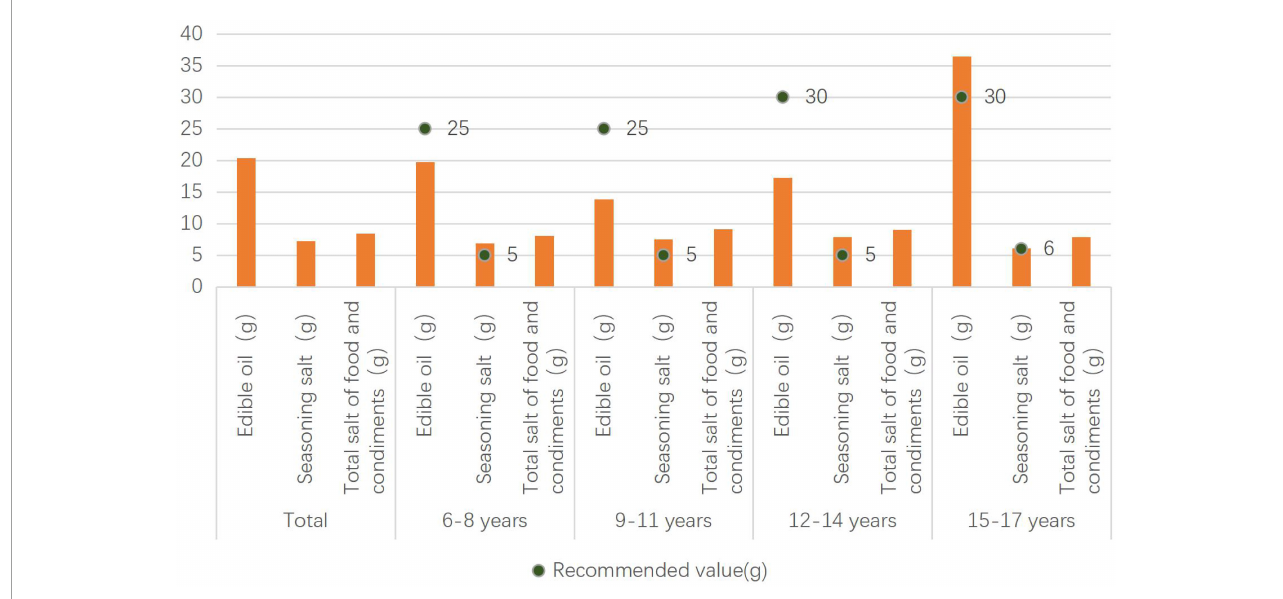
FIGURE3 Edible oil and seasoning salt intake of rural children and adolescents.